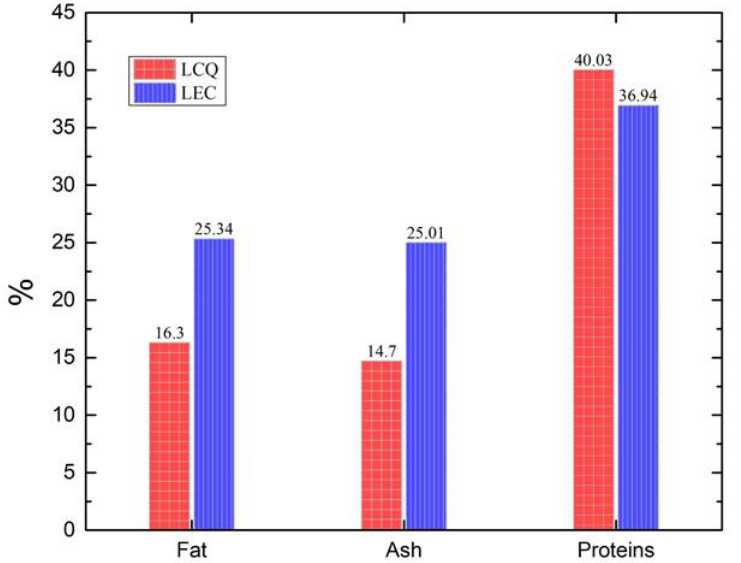
Figure 3. Proximal composition on a dry basis of the sludge obtained by LCQ and LEC. The bar values represent the average of all the batches worked.